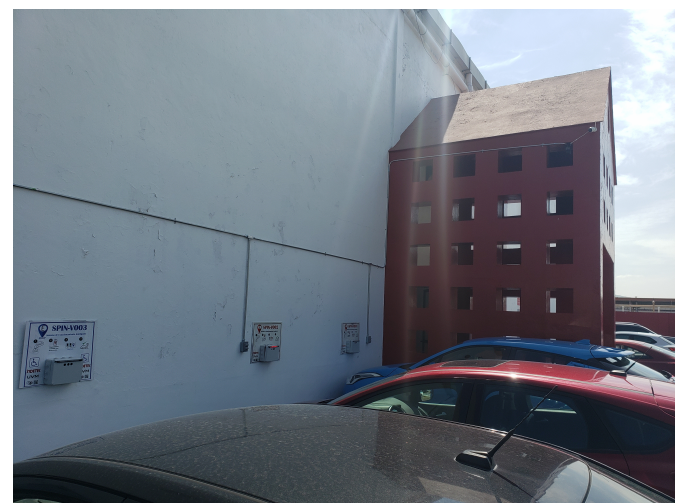
Figure 20. Three SPIN-V Installed in UVM.